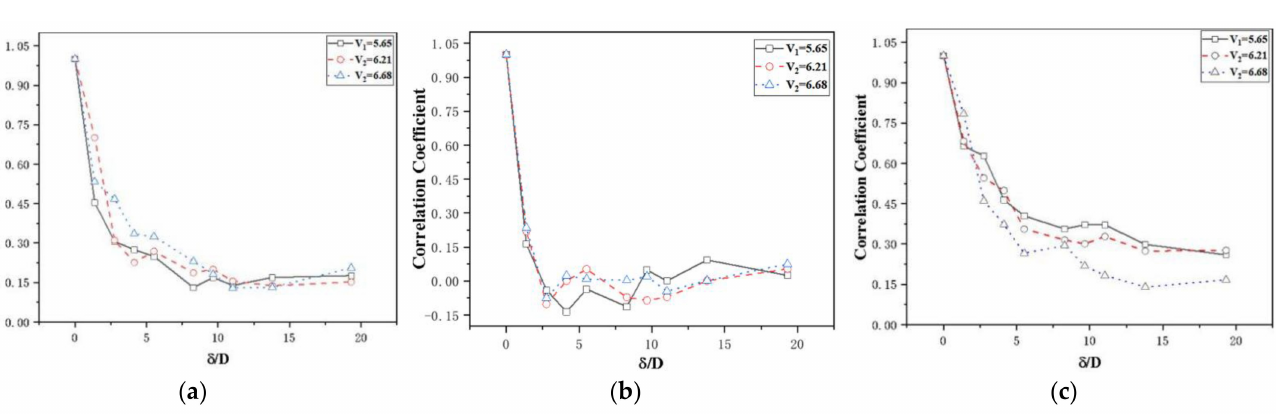
Figure 13. Spanwise correlation of wake wind velocity of the main beam in the vibrational state. ( a ) Spanwise correlation of along-wind fluctuating wind velocity; ( b ) Spanwise correlation of across- wind fluctuating wind velocity; ( c ) Spanwise correlation of vertical-wind fluctuating wind